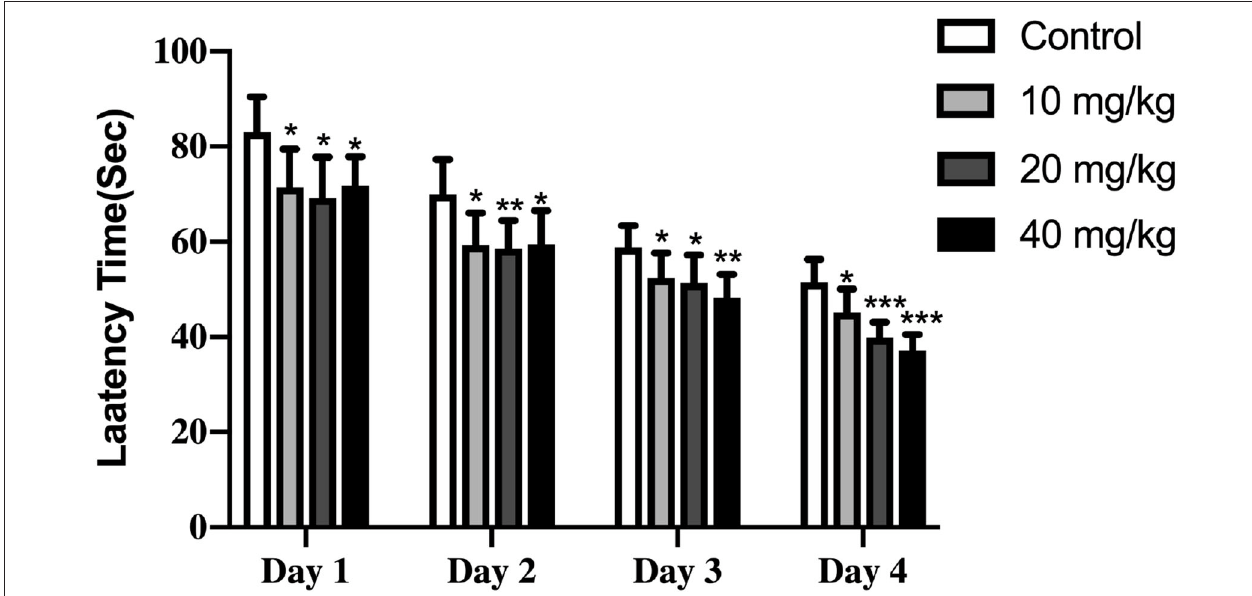
FIGURE 2 | Effects of perinatal Neu5Ac exposure on the latency to find the platform in the Morris water maze test in 100-day-old male rat offspring. Mother rats were treated with Neu5Ac [10, 20, or 40 mg/(kg · day)] or water (as control) from gestational day 15 to postnatal day 21. The results are expressed as the M ± SD ; n = 10 per group. * P < 0.05, ** P < 0.01, *** P < 0.001 indicate a significant difference compared with control-group rats.